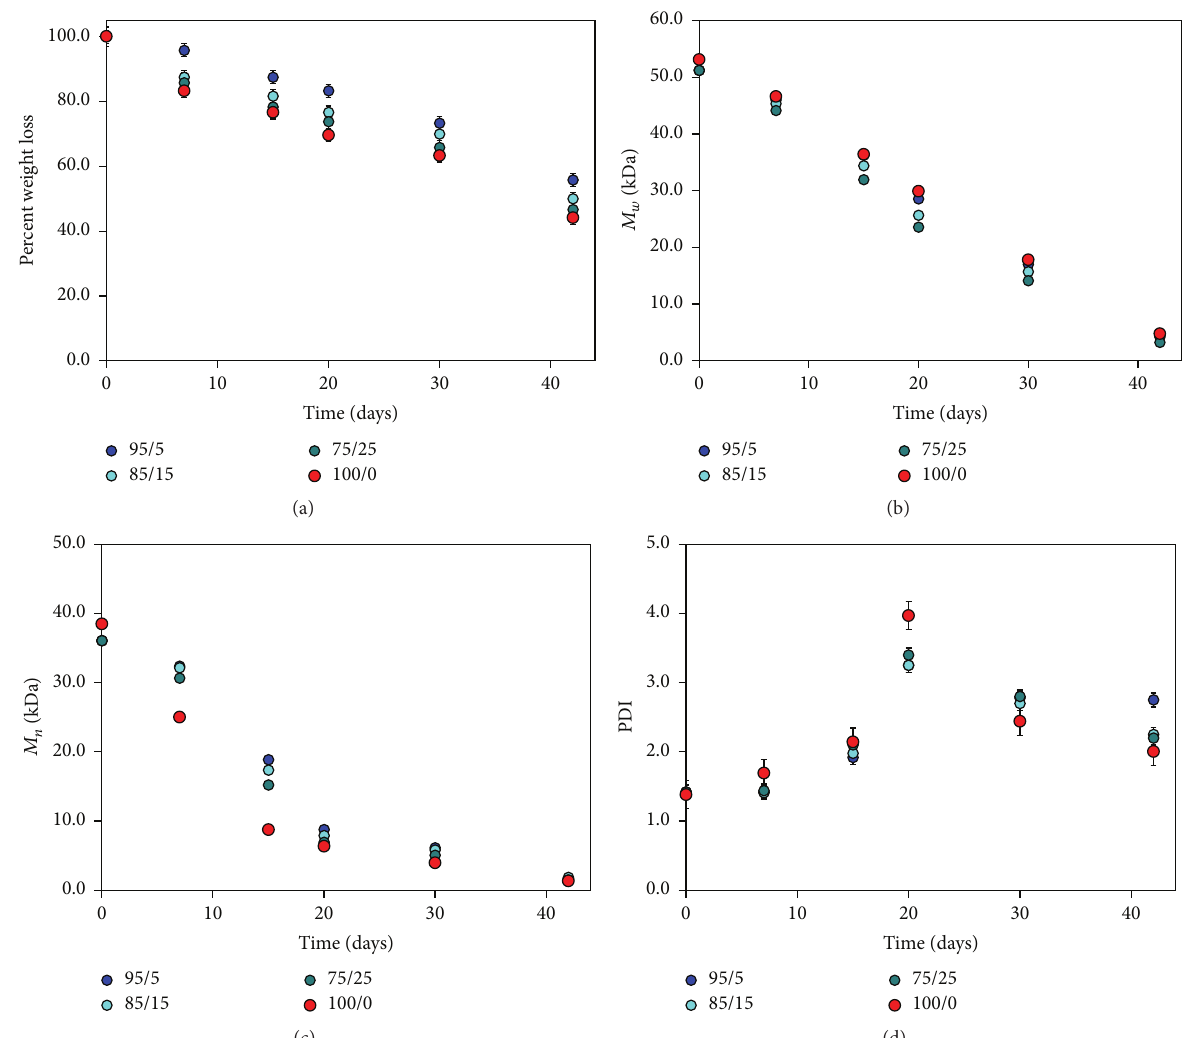
Figure 3: Degradation study for nonmicrostructured PLGA/gelatin materials at different composition in aqueous solution. (a) Trend of percentage weight loss versus time for PLGA/gelatin samples; (b) change of weight average molecular weight ( M ) versus time; (d) polydispersity index (PDI) as function with trend of number average molecular weight ( M n